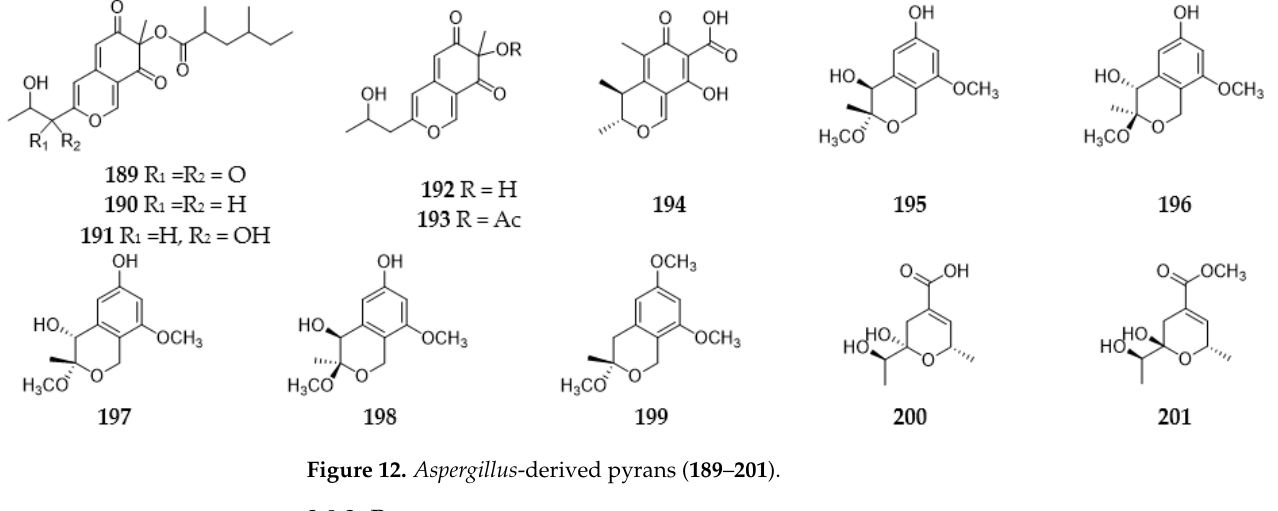
Figure 13. Aspergillus -derived pyranones ( 202 – 219 ). By the heterologous expression of the avirulence gene ACE1 in A. oryzae M-2-3, two new polyenyl- α -pyranones ( 209 and 210 ) were produced and shown to be not responsible for the observed ACE1 -mediated avirulence [105]. (+)-Asperlin ( 211 ) was discovered from an A. nidulans mutant, which fused the DNA-binding domain of a transcription factor associated with a silent SM gene cluster with the activation domain of a robust SM tran- scription factor AfoA [106]. Deletion of the epigenetic regulator gene, a histone acetyltrans- ferase in the SAGA/ADA complex, resulted in the production of a novel compound, ni- gerpyrone ( 212 ) in A. niger FGSC A1279 [107]. Moreover, its biosynthetic pathway was disclosed via gene knockout and complementation experiments (Scheme 4). Aspopyrone A ( 213 ) was produced by an Okinawan plant-derived fungus, A. sp. TMPU1623 exhibited a strong inhibitory effect on protein tyrosine phosphatase (PTP) 1B with an IC 50 value of